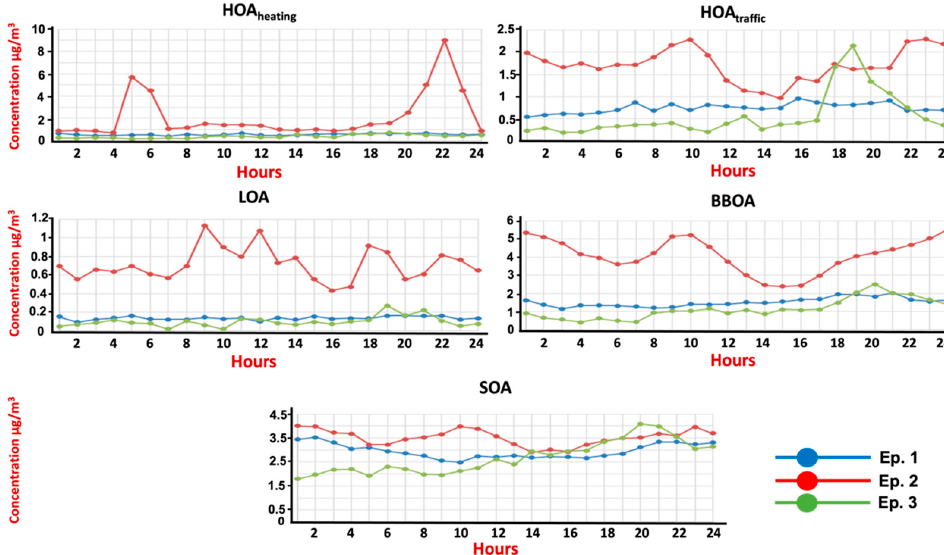
Figure 6. Diurnal patterns of the five OA factors (HOA heating , HOA traffic , LOA, BBOA, and SOA) determined based on the PMF analysis.